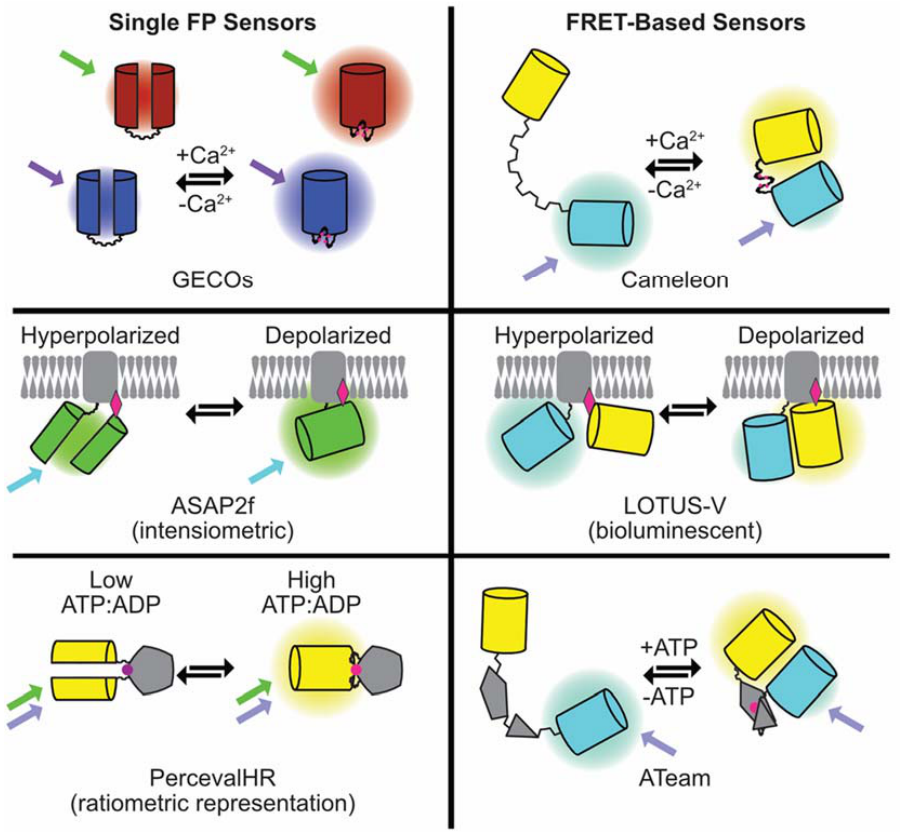
Figure 2. Summary of the composition and mode of action of the genetically ‐ encoded fluorescent sensors for Ca 2+ , voltage, and ATP discussed in the article.